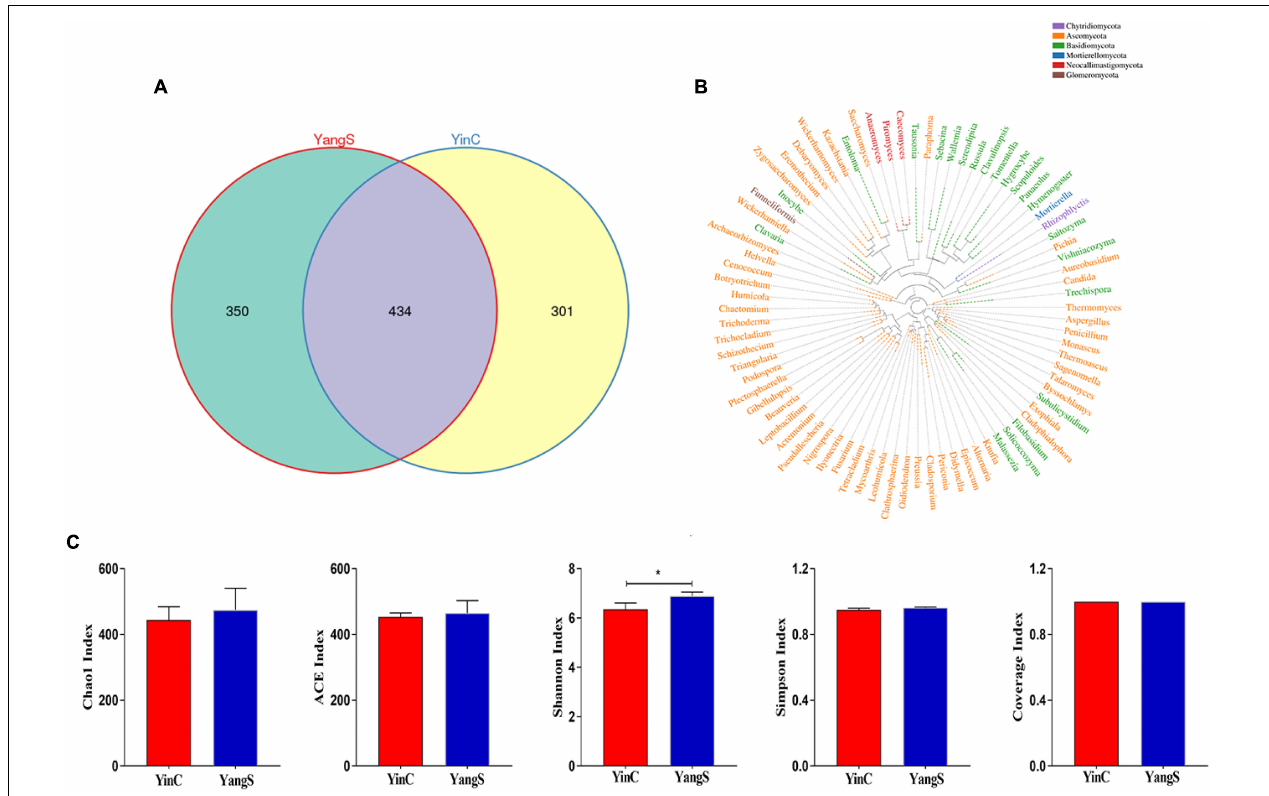
FIGURE 3 | Fungal microbial diversity index and OTUs analysis. (A) Unique and core OTUs of fungal community; (B) phylogenetic tree at genus level of fungal community; (C) alpha diversity indexes.